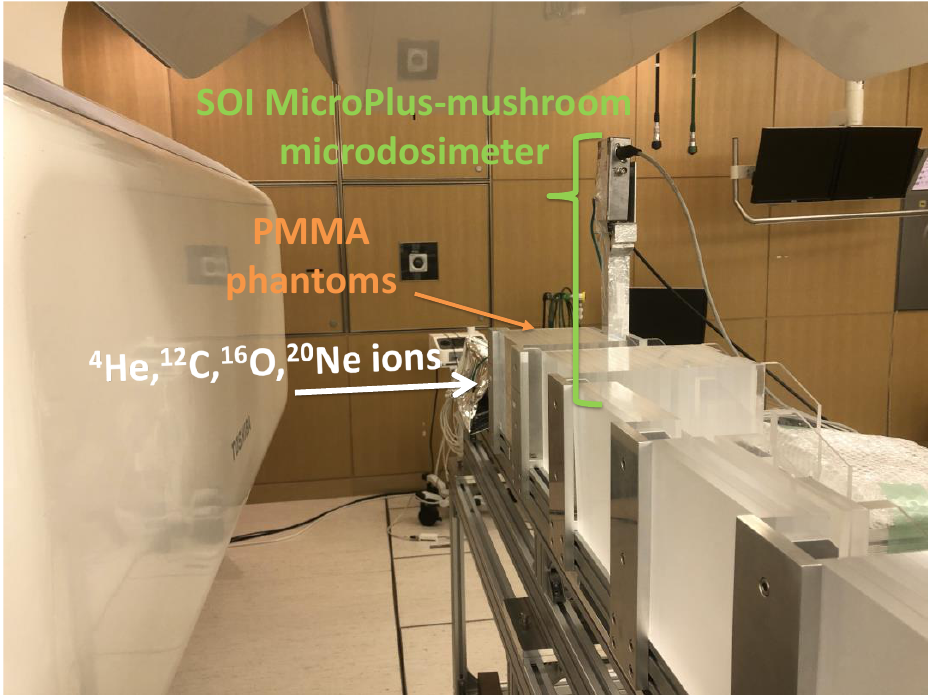
Figure 1. Photo of the experimental set-up with the SOI MicroPlus-mushroom microdosimeter positioned vertically behind PMMA phantoms in the horizontal scanning-beam port at NIRS-HIMAC.